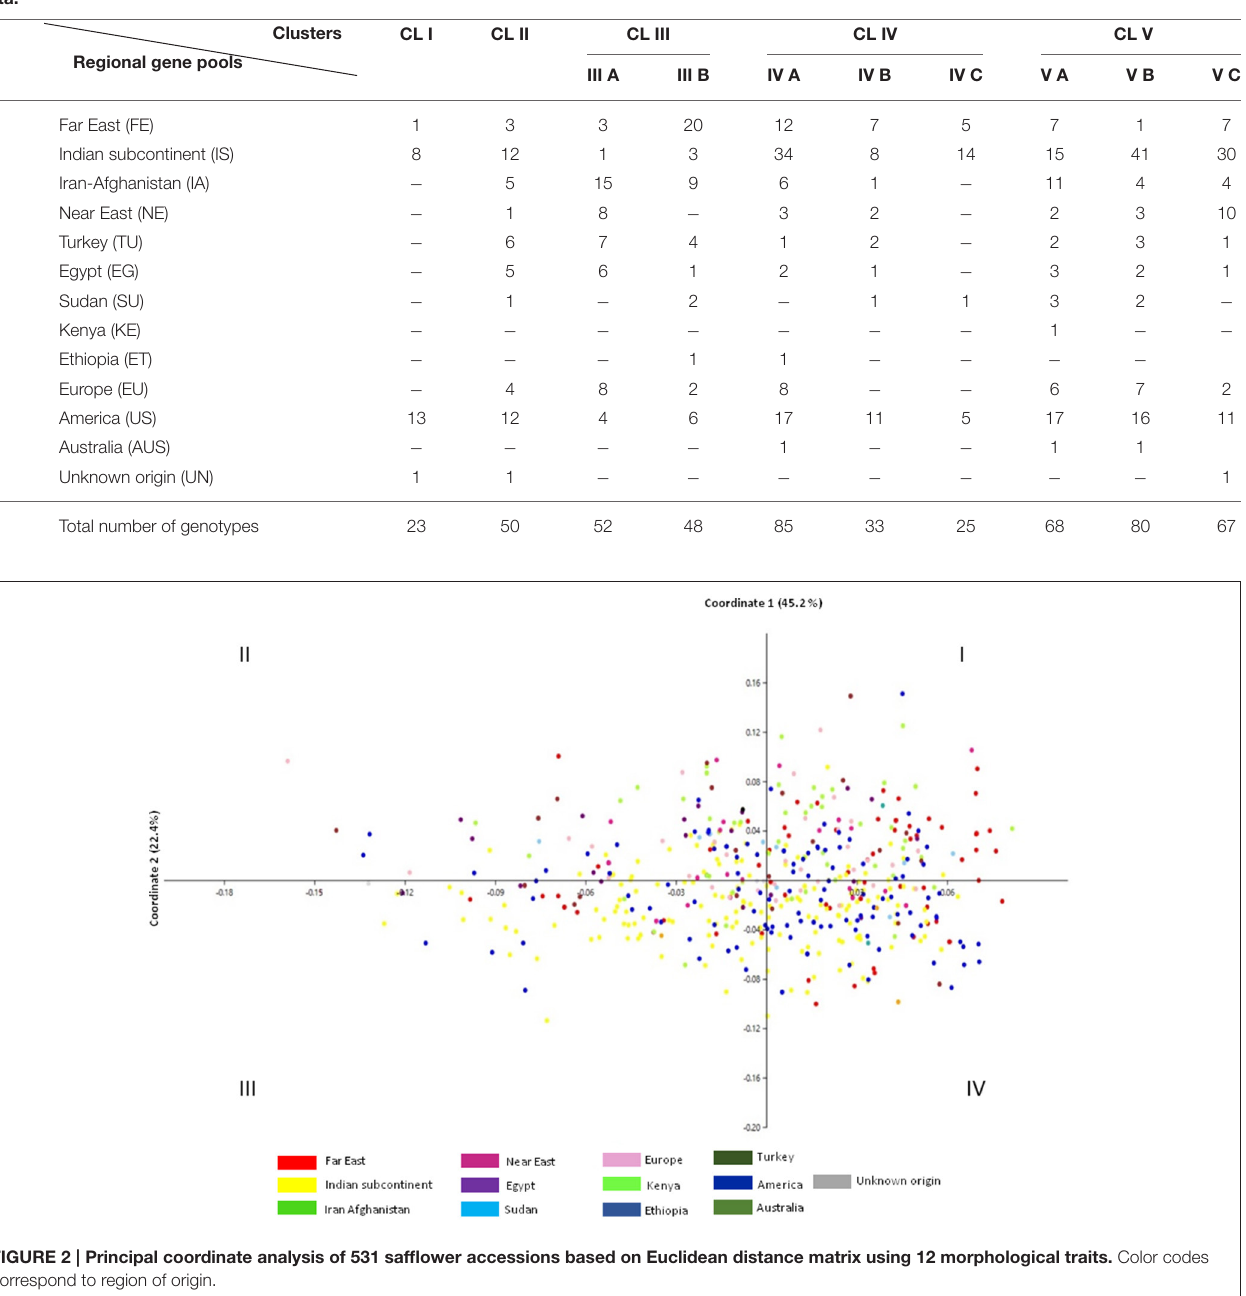
TABLE 3 | Distribution of accessions from different regional gene pools of safflower in clusters of UPGMA dendrogram constructed using phenotypic data.